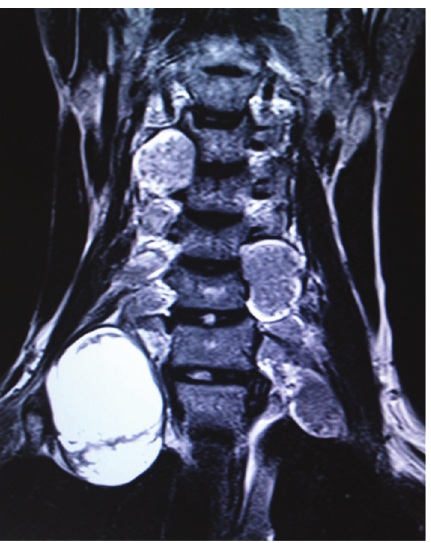
Figure 2: Coronal T2 weighted MR image showing multiple variable sized intra- and extradural dumbbell-shaped tumours in cervical and upper thoracic region suggestive of spinal and extraspinal